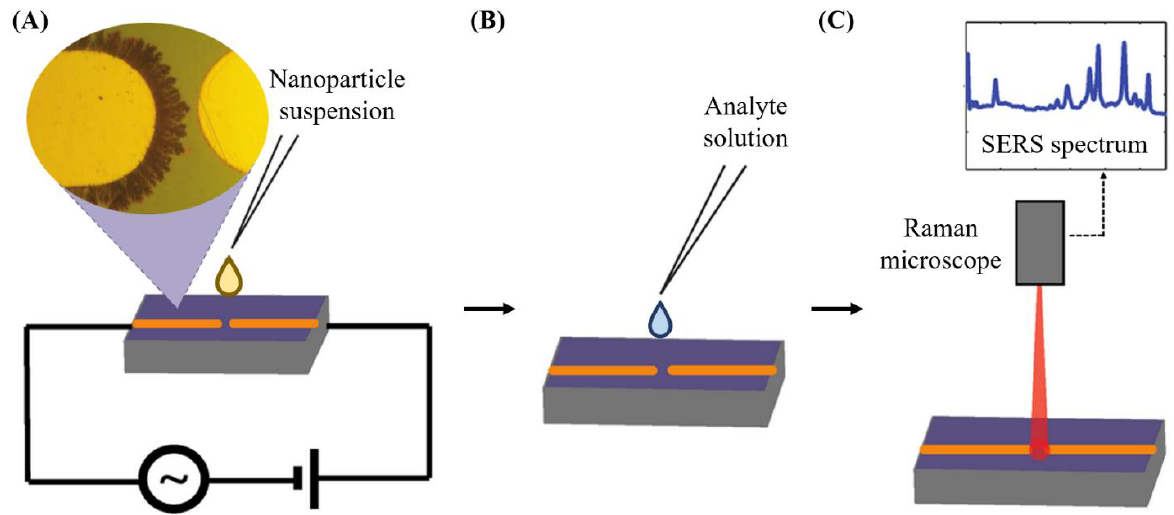
Figure 6. Preparation of SERS substrate used for the detection of food contaminants in liquid food. ( A ) Formation of SERS-active nanostructures. ( B ) Addition of analyte solution to the surface of the microelectrodes. ( C ) SERS detection of the analyte [60].